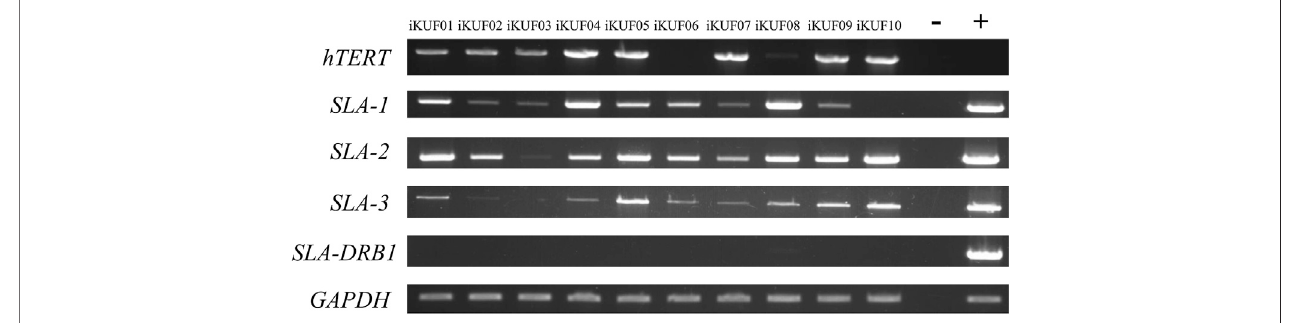
FIGURE 4 | Comparison of the expression of SLA-1, -2, -3 , and -DRB1 in immortalized fi broblast cell lines. Semi quantitative reverse transcription PCRs were carried out for SLA-1, -2, -3 , and -DRB1 . GAPDH was used as a control. The numbers of the cell lines are on top. “–” and “ + ” indicate negative and positive controls, respectively. The representative image from the triplicate analysis is